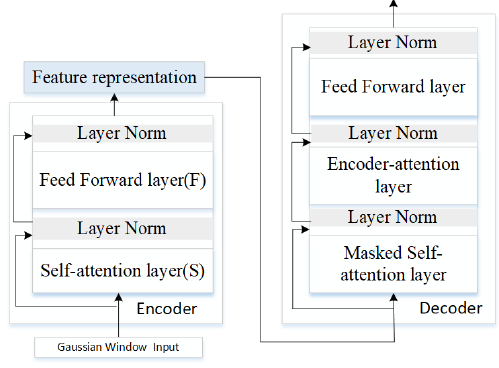
Figure 4. Transformers with attention mechanisms.